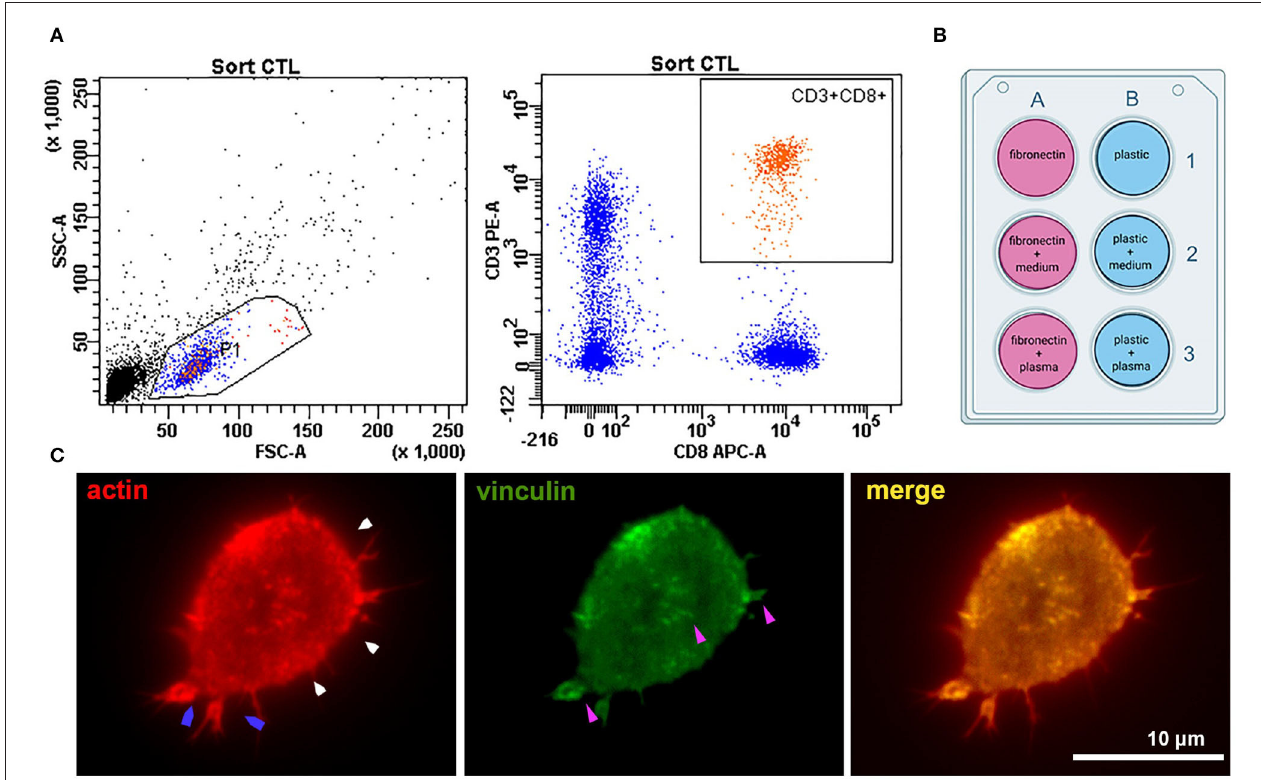
FIGURE 1 | Experiment setup and cell adhesion metrics were calculated for all types of coating. (A) Sorting CTLs from peripheral blood; the gates are set on the CD3 + CD8 + T-cell population. (B) The six types of surface coating tested for each experiment. Fibronectin coating was applied for 45min at room temperature – 100 µ l of 50 µ g/ml solution per 1 cm 2 surface. Fibronectin coating was air-dried before applying other ligands. Plasma and conditioned culture medium were stored after centrifugation at − 80 ◦ C and thawed only once to coat the surfaces for T-cell seeding. Conditioned medium for coating in all experiments was derived from one batch (medium conditioned for 3 days by an atherosclerotic plaque explants from a male patient (age 61 years) with an ischemic stroke and atherosclerosis of carotid artery). Plasma was used from four different batches – one batch for each patient + donor pair (by number, as provided in Supplementary Table 1 ). All plasma was obtained from patients with confirmed atherosclerosis of carotid arteries and neurological symptoms (thrombosis and stroke) (C) Representative fluorescence image of a CD8 + T-lymphocyte seeded on a coverslip (patient 2, fibronectin coating) and stained against actin and vinculin after 24 h’ incubation. The cell forms small lamellipodia (blue arrows), actin is organized into a thin cortical network (white arrows). Focal adhesions (purple arrows, visualized by anti-vinculin fluorescence staining) form spots mostly at the T-cell